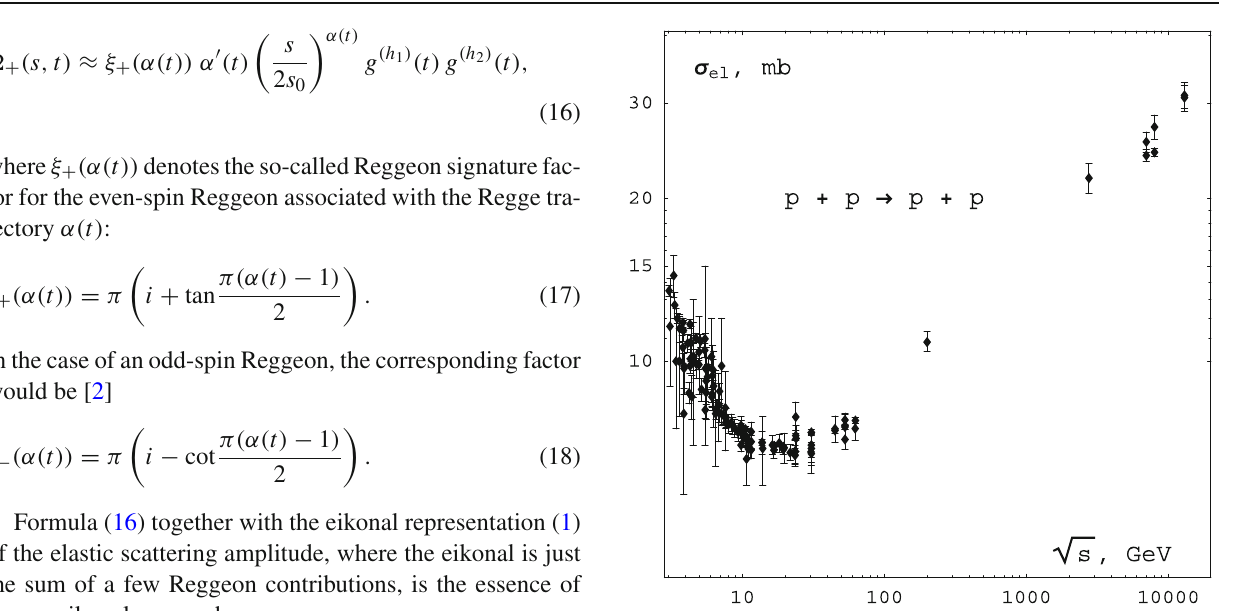
Fig. 1 The energy evolution of the p p EDS integrated cross-section